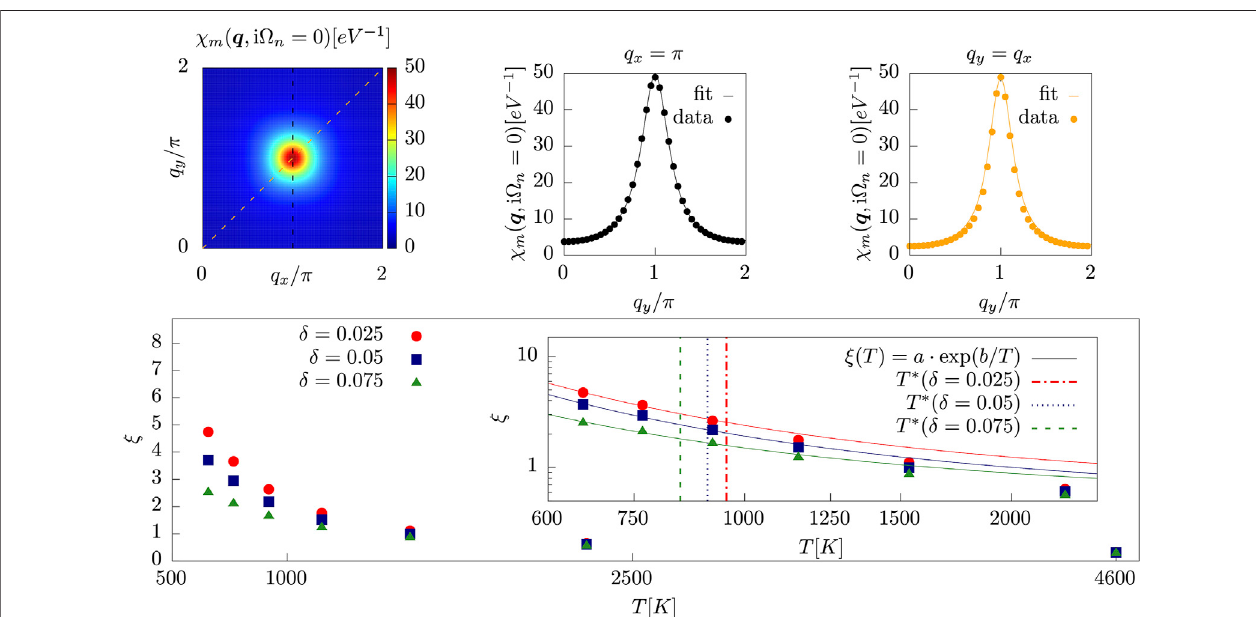
FIGURE5| Top,fromlefttoright: χ m ( q , i Ω n =0), χ m ( q =( q x , π ), i Ω n =0),and χ m ( q =( q x , q x ), i Ω n =0)foradopingof δ =7.5 % andatemperatureof960K,calculated by D Γ A. Circles denote calculated points, the solid line an Ornstein-Zernike fi t by Eq. 3 . Bottom: Correlation lengths ξ of D Γ A plotted over the temperature for different dopings. The insets shows a double-logarithmic plot and temperature fi ts [see text and Eq. 4 ].